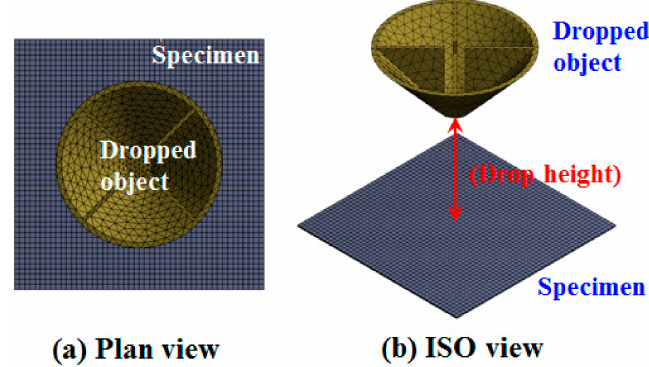
Figure 18. Finite element model for drop impact